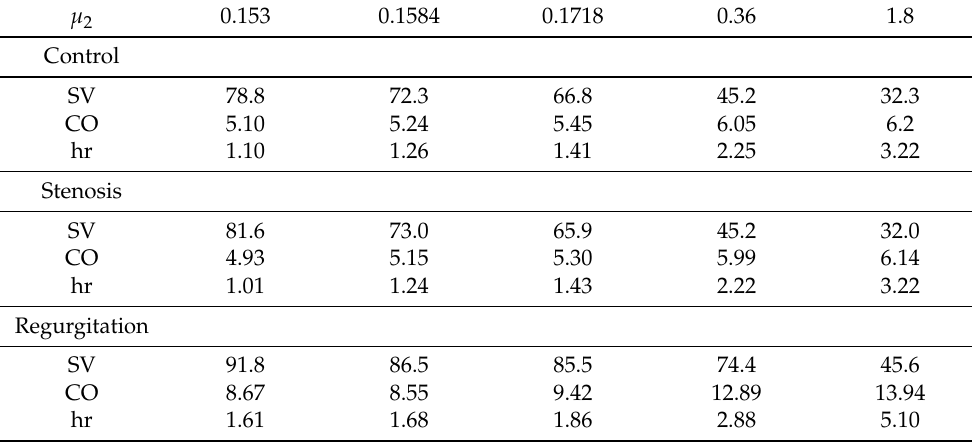
Table 8. Effect of µ 2 with a severe aortic valve stenosis or